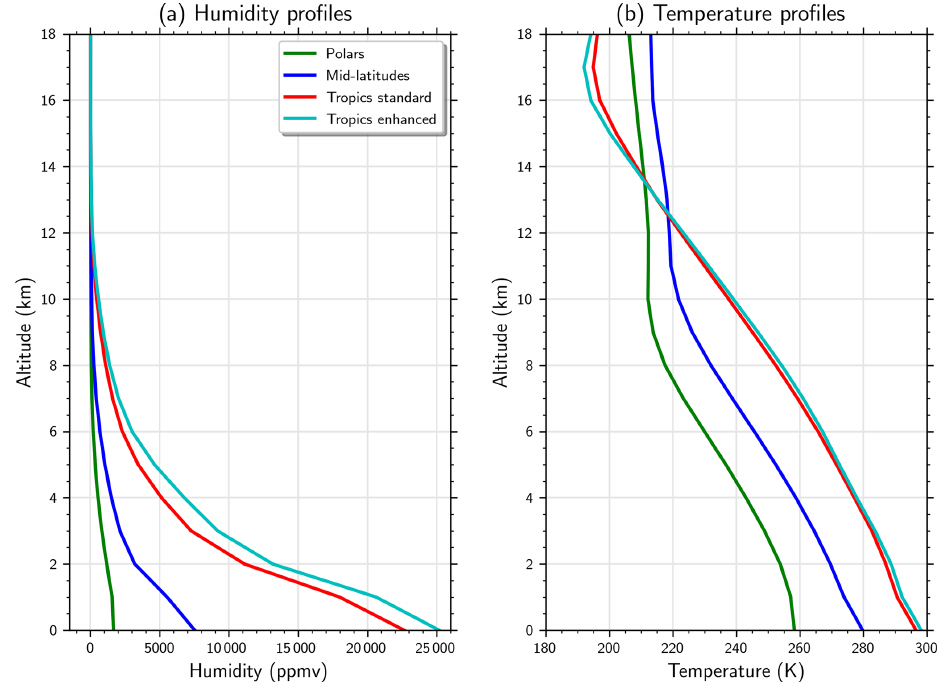
Figure A4. Annual mean profiles of temperature and humidity from